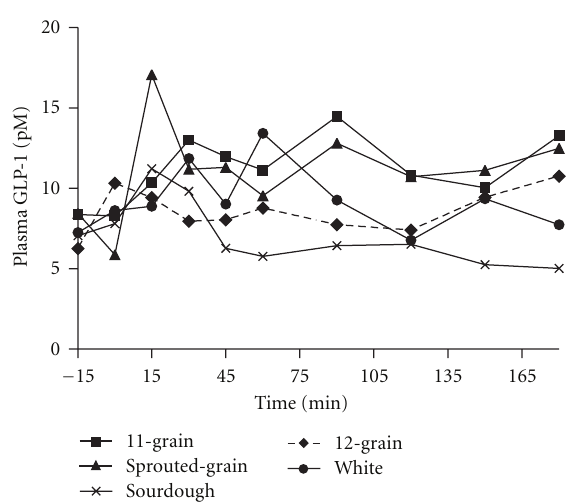
Figure 4: Fasting and postprandial insulin responses to the inges- tion of a consistent amount of the test breads. Test bread was ingested after collection of fasting blood sample at time point − 15 min. Data are means. Standard errors are not included for clarity, n = 11. Significant overall treatment e ff ects were found in insulin response to the breads (sprouted-grain bread was lower than 12-grain ( P < 0 . 03) bread, and 12-grain bread was lower than sourdough ( P < 0 . 001) and white ( P < 0 . 001) breads). 0 . 03) and white ( P < 0 . 001) breads (Table 4). Despite